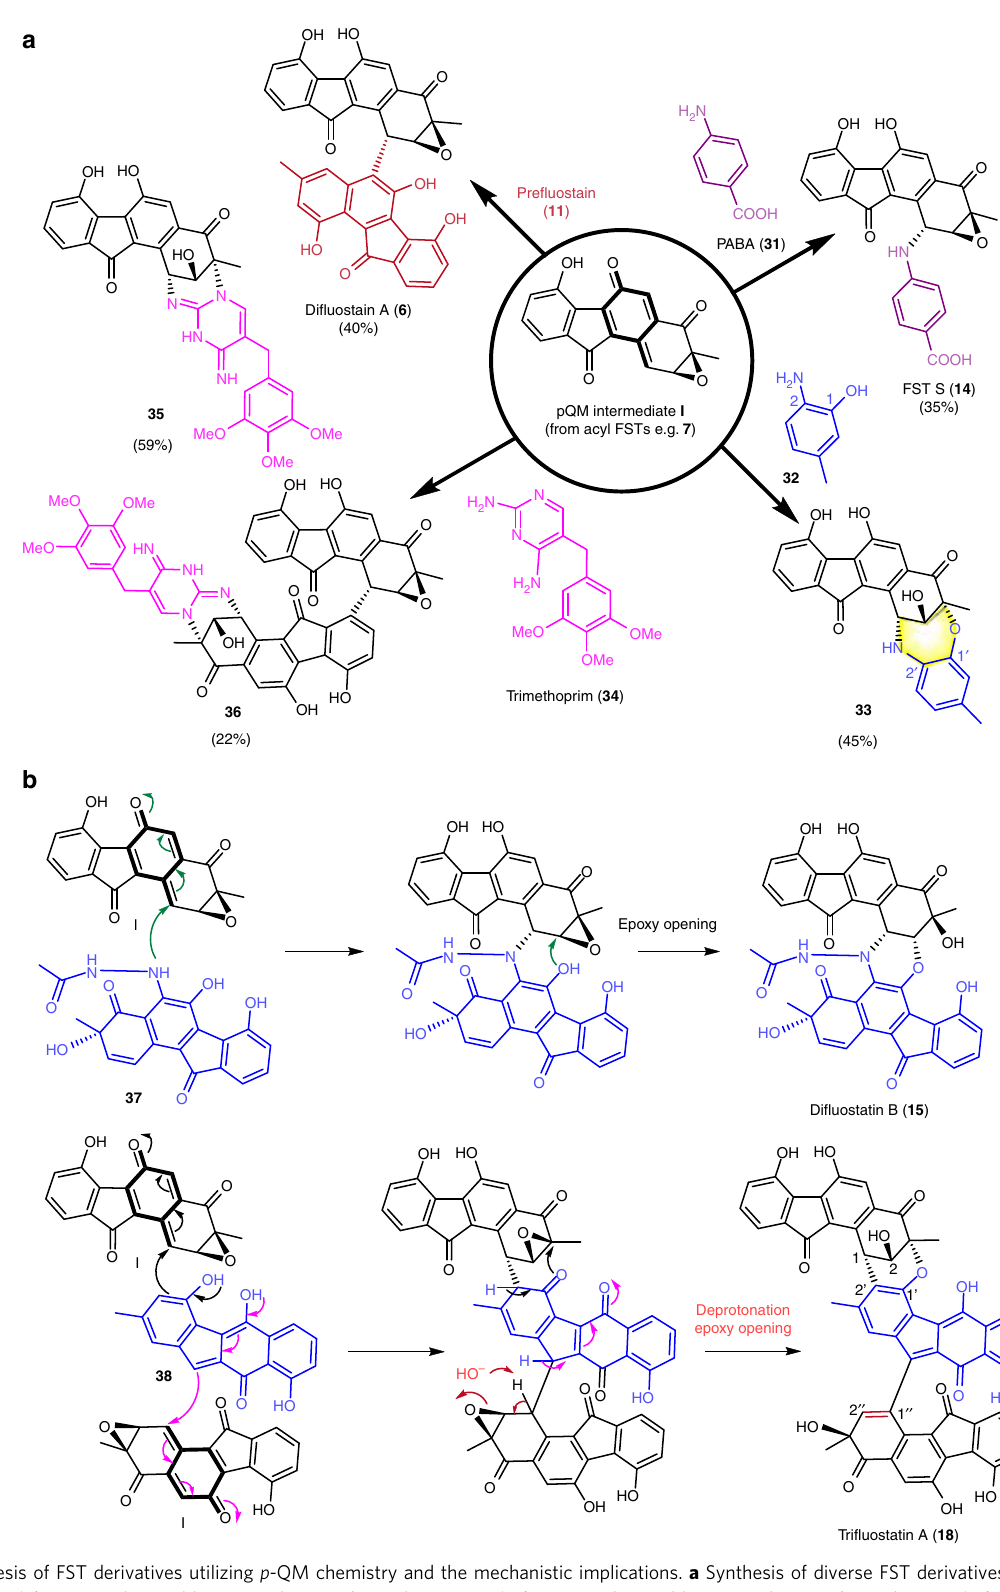
Fig. 6 Synthesis of FST derivatives utilizing p -QM chemistry and the mechanistic implications. a Synthesis of diverse FST derivatives from FST D ( 7 ). Di fl uostatin A ( 6 ) was synthesized by co-incubation of 7 and 11 ; FST S ( 14 ) was synthesized by co-incubation of 7 and PABA ( 31 ); compound 33 was synthesized by co-incubation of 7 and 2-amino-5-methylphenol ( 32 ); 35 and 36 were synthesized by co-incubation of 7 and trimethoprim ( 34 ). For each reaction, an incubation in H 2 O was performed overnight at room temperature. The conversion rate of each compound is indicated in parenthesis. b The proposed p -QM ( I )-mediated spontaneous formation of di fl uostatin B ( 15 ) and tri fl uostatin A ( 18 )